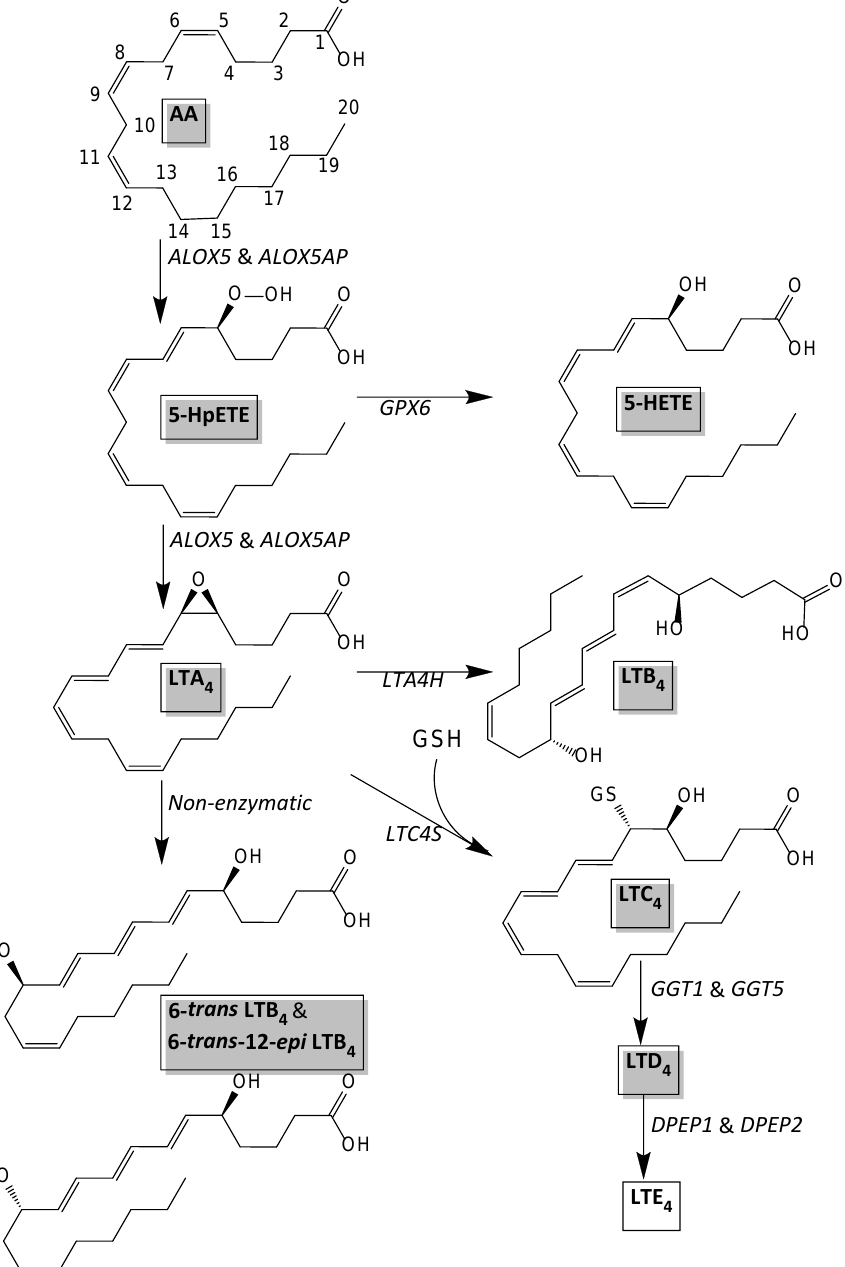
Figure 4. Leukotriene biosynthesis pathway based on Murphy et al. [30].